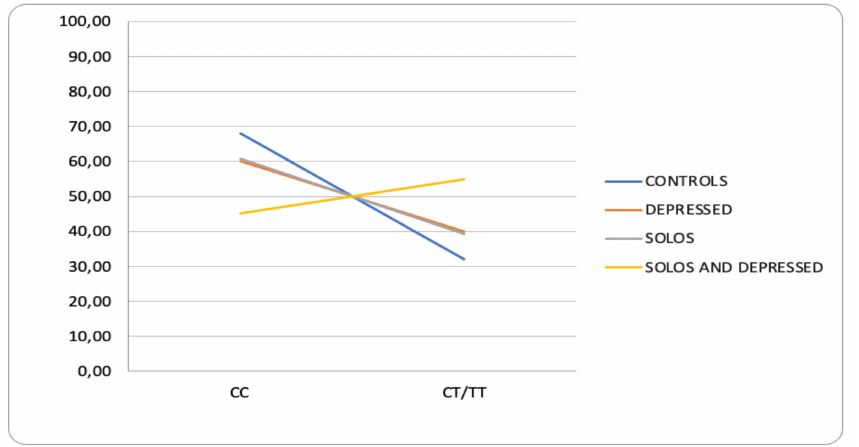
Figure 3. Representation of the frequencies of the genotypes of rs6265 (BDNF) with respect to the groups: controls, depressed, solo, and solo and